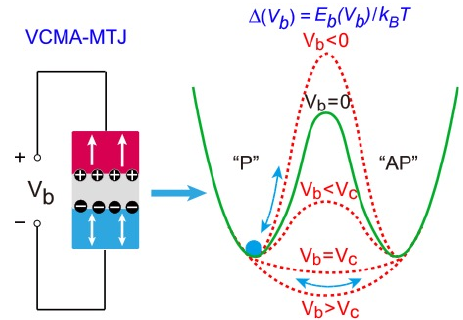
Figure 2. Typical structure of the voltage ‐ controlled magnetic anisotropy (VCMA) ‐ MTJ device. The applied voltage amplitude (V b ) and critical voltage (V c ) determine the operation regimes of VCMA ‐ MTJ: thermally assisted, precessional switching and STT ‐ assisted precessional switching.